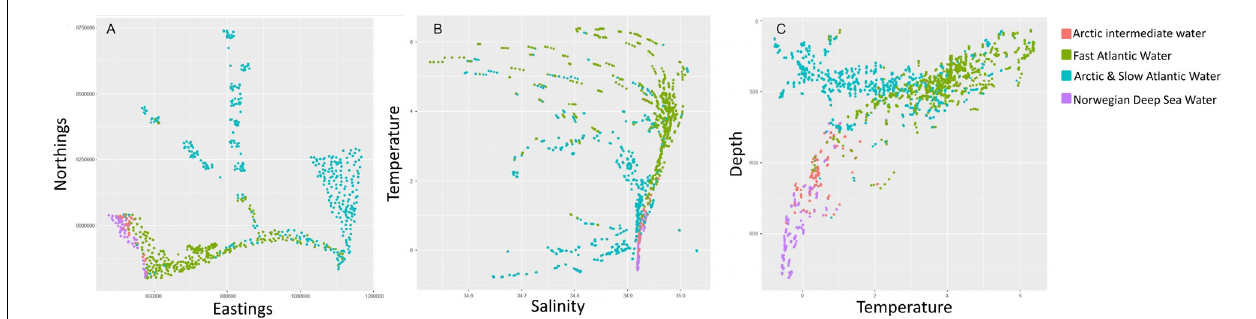
FIGURE 5 | Example of environmental patterns of sample groups identified by the first two divisions of the TWINSPAN of the species dataset with the main clusters indicated in different colors. (A) Geographical distribution, (B) temperature vs. salinity, and (C) Depth vs. temperature.